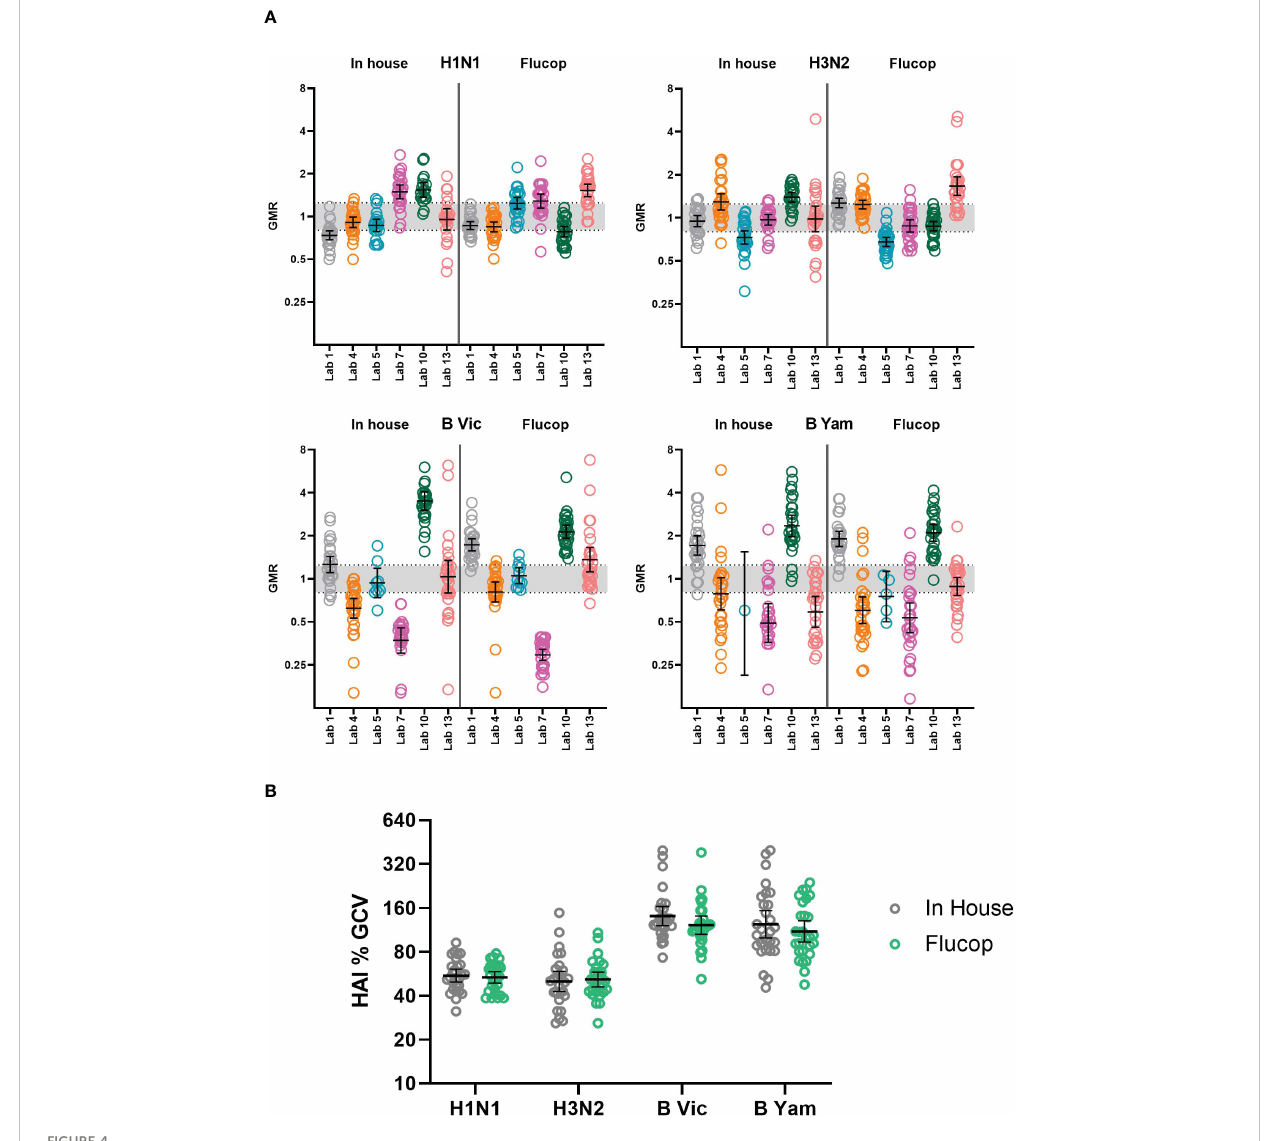
FIGURE 4 Impact of using the FLUCOP protocol on inter-laboratory variation in HAI testing. (A) GMR of each sample HAI titre tested across 6 laboratories using both in-house (left in each graph) and FLUCOP (right in each graph) protocols. GMR was calculated as the ratio of a sample HAI titre compared to the GMT of that sample using in-house methods (for in-house GMRs) or using FLUCOP methods (for FLUCOP GMRs). Geometric mean and 95% CI are plotted in black. The indicative interval of 0.8-1.25 is shaded in grey. Each laboratory has a unique number and colour in all graphical representation of data. (B) %GCV for each sample HAI titre tested across 6 laboratories using both in-house protocols (grey) and a FLUCOP protocol (green). Geometric mean and 95% CI are plotted in